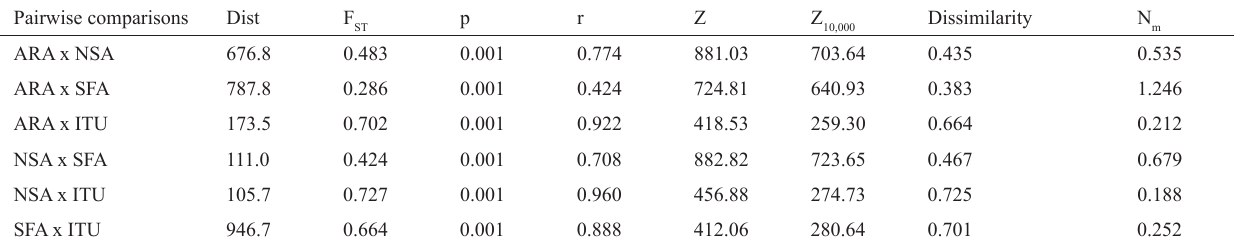
Table 2. Pairwise comparison of Arapaima gigas populations. (Dist) Approximate distance in km; ( F genetic differentiation index; (p) significance level; (r) correlation of two matrices; (Z) robustness of the relationship with the original data and (Z10,000) after 10,000 permutations; genetic dissimilarity using the Jaccard coefficient; (Nm) estimated number of migrants per generation. (ARA) Araguaiana-MT, (NSA) Novo Santo Antônio-MT, (SFA) São Félix do Araguaia- MT and (ITU)